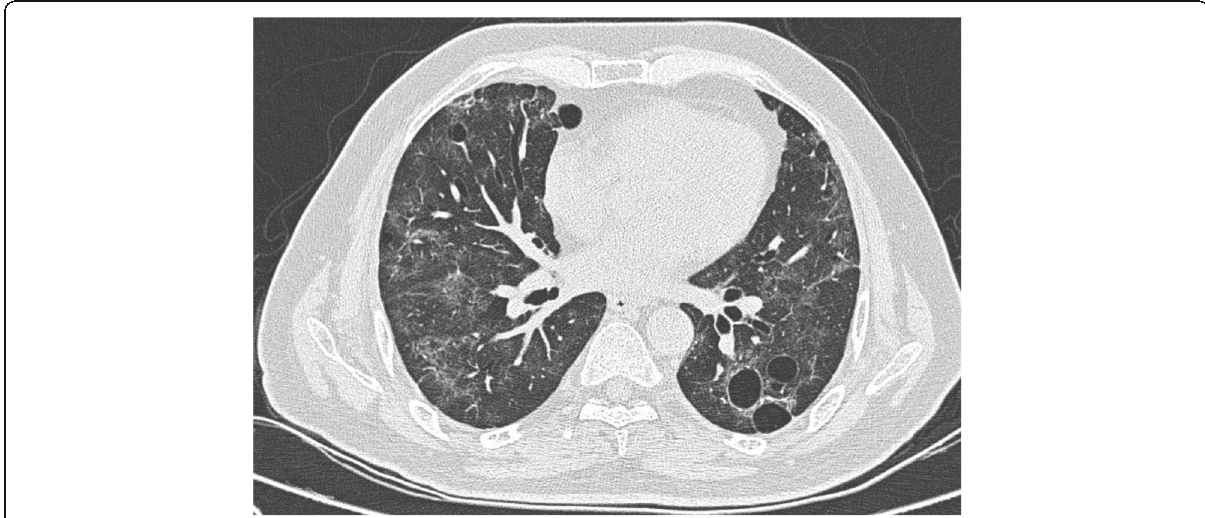
Fig. 1 Axial CT thorax of a 60-year-old COVID pneumonia patient showing multiple thin-walled air-filled cystic lesion in the bilateral lower lobes. Areas of GGOs with interlobular septal thickening are also